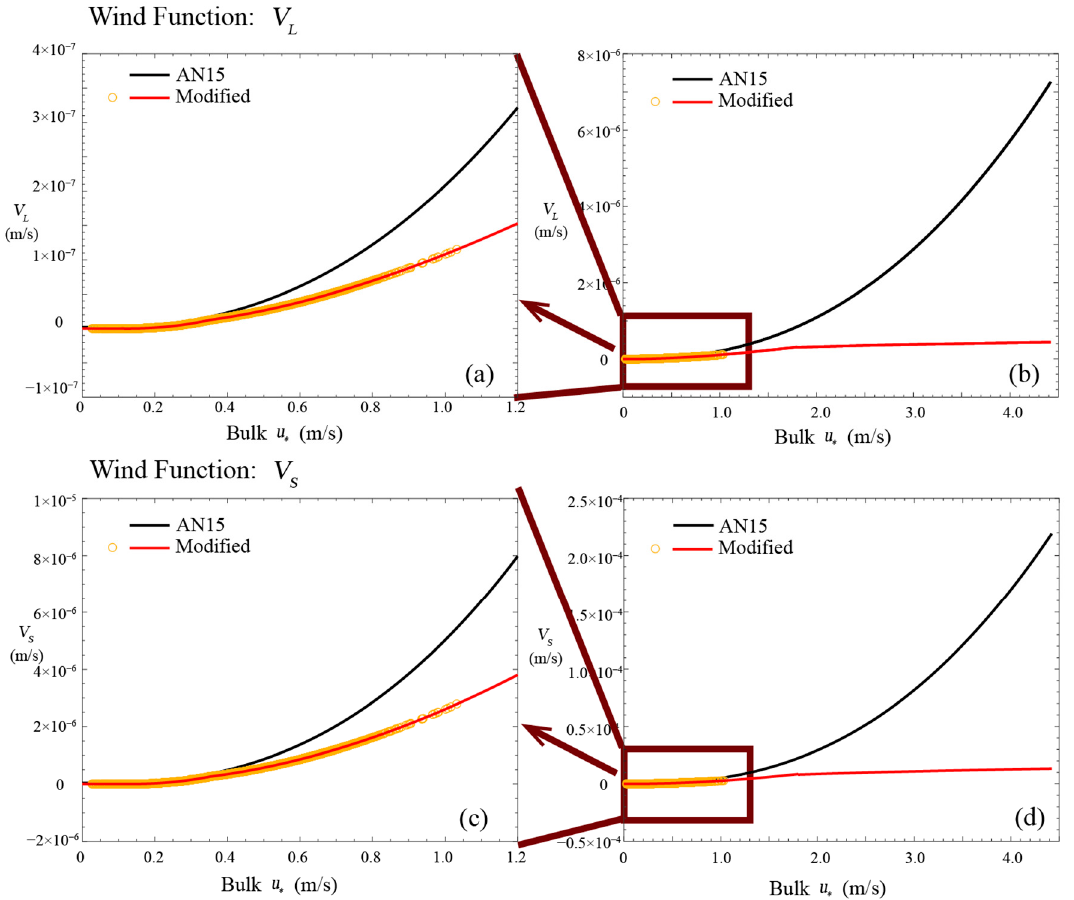
Figure 6. Comparison of the new and the original wind functions V L and V S . The black curve represents the wind functions V L and V S in AN15. The yellow circles represent the values of new wind functions calculated by the modified scheme with the measurements in the FASTEX. The red curve represents the new wind functions, which are fitted with a cubic polynomial based on the yellow circles. ( a , c ) reflect the wind functions V L and V S under low to moderate wind speed conditions; ( b , d ) reflect the wind functions V L and V S under low to high wind speed conditions. ( a , c ) are parts of ( b , d ), and the rectangular boxes in ( b , d ) represent the extent of ( a , c